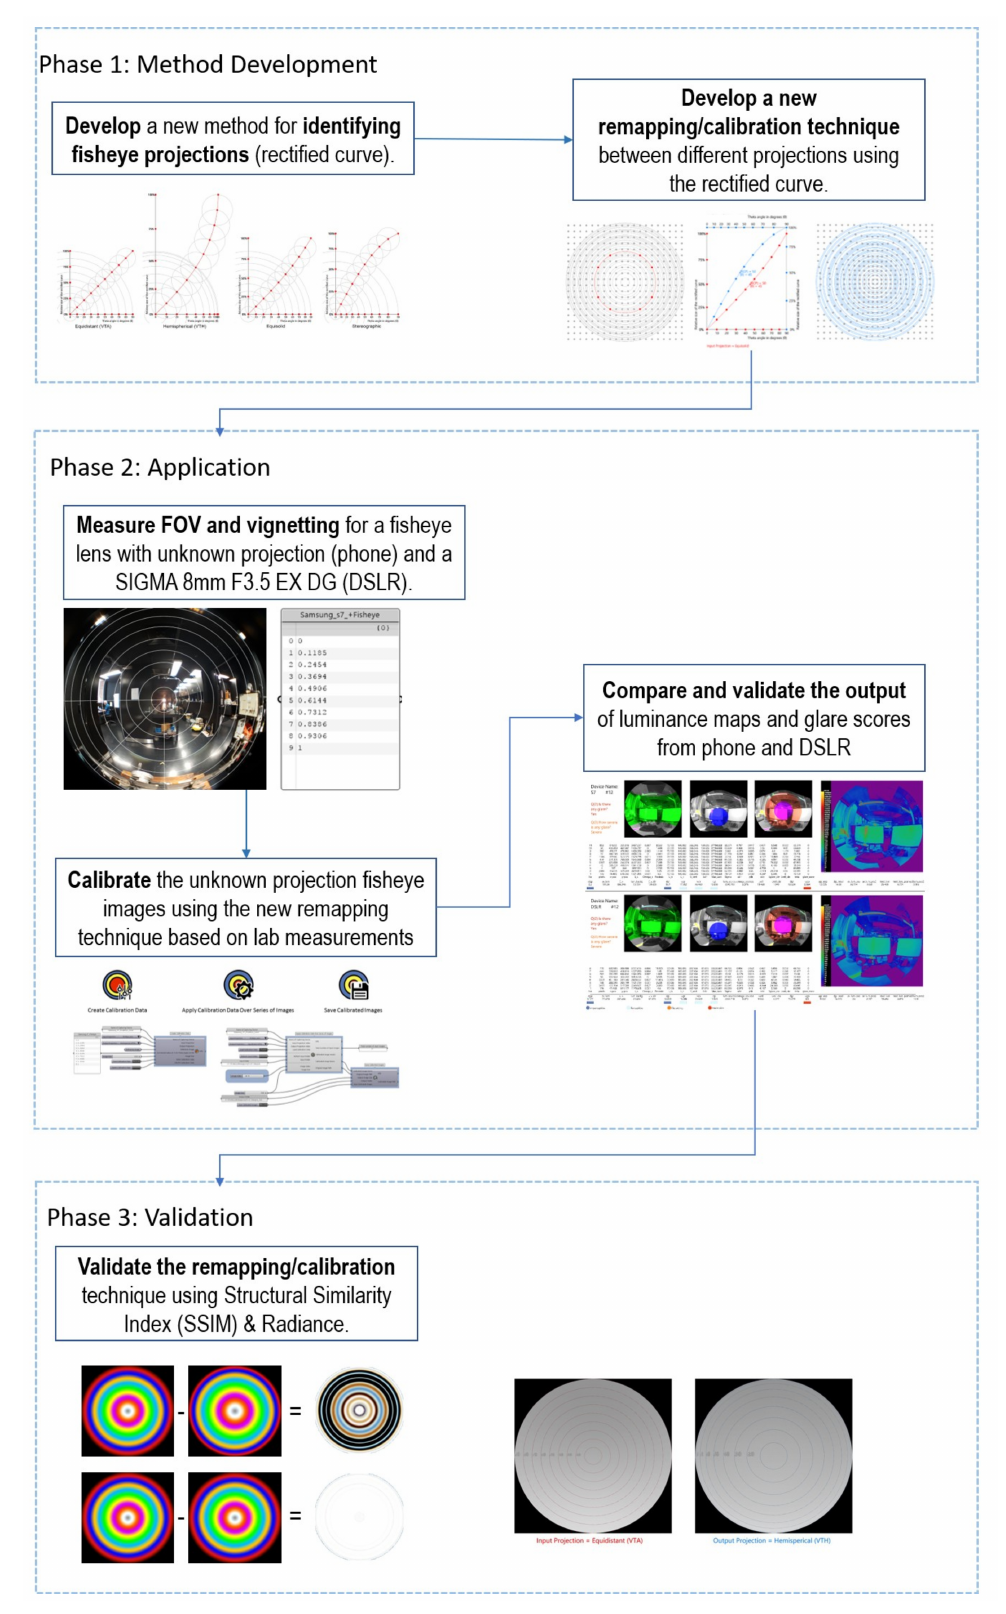
Figure 3. Methodological workflow diagram showing the three major